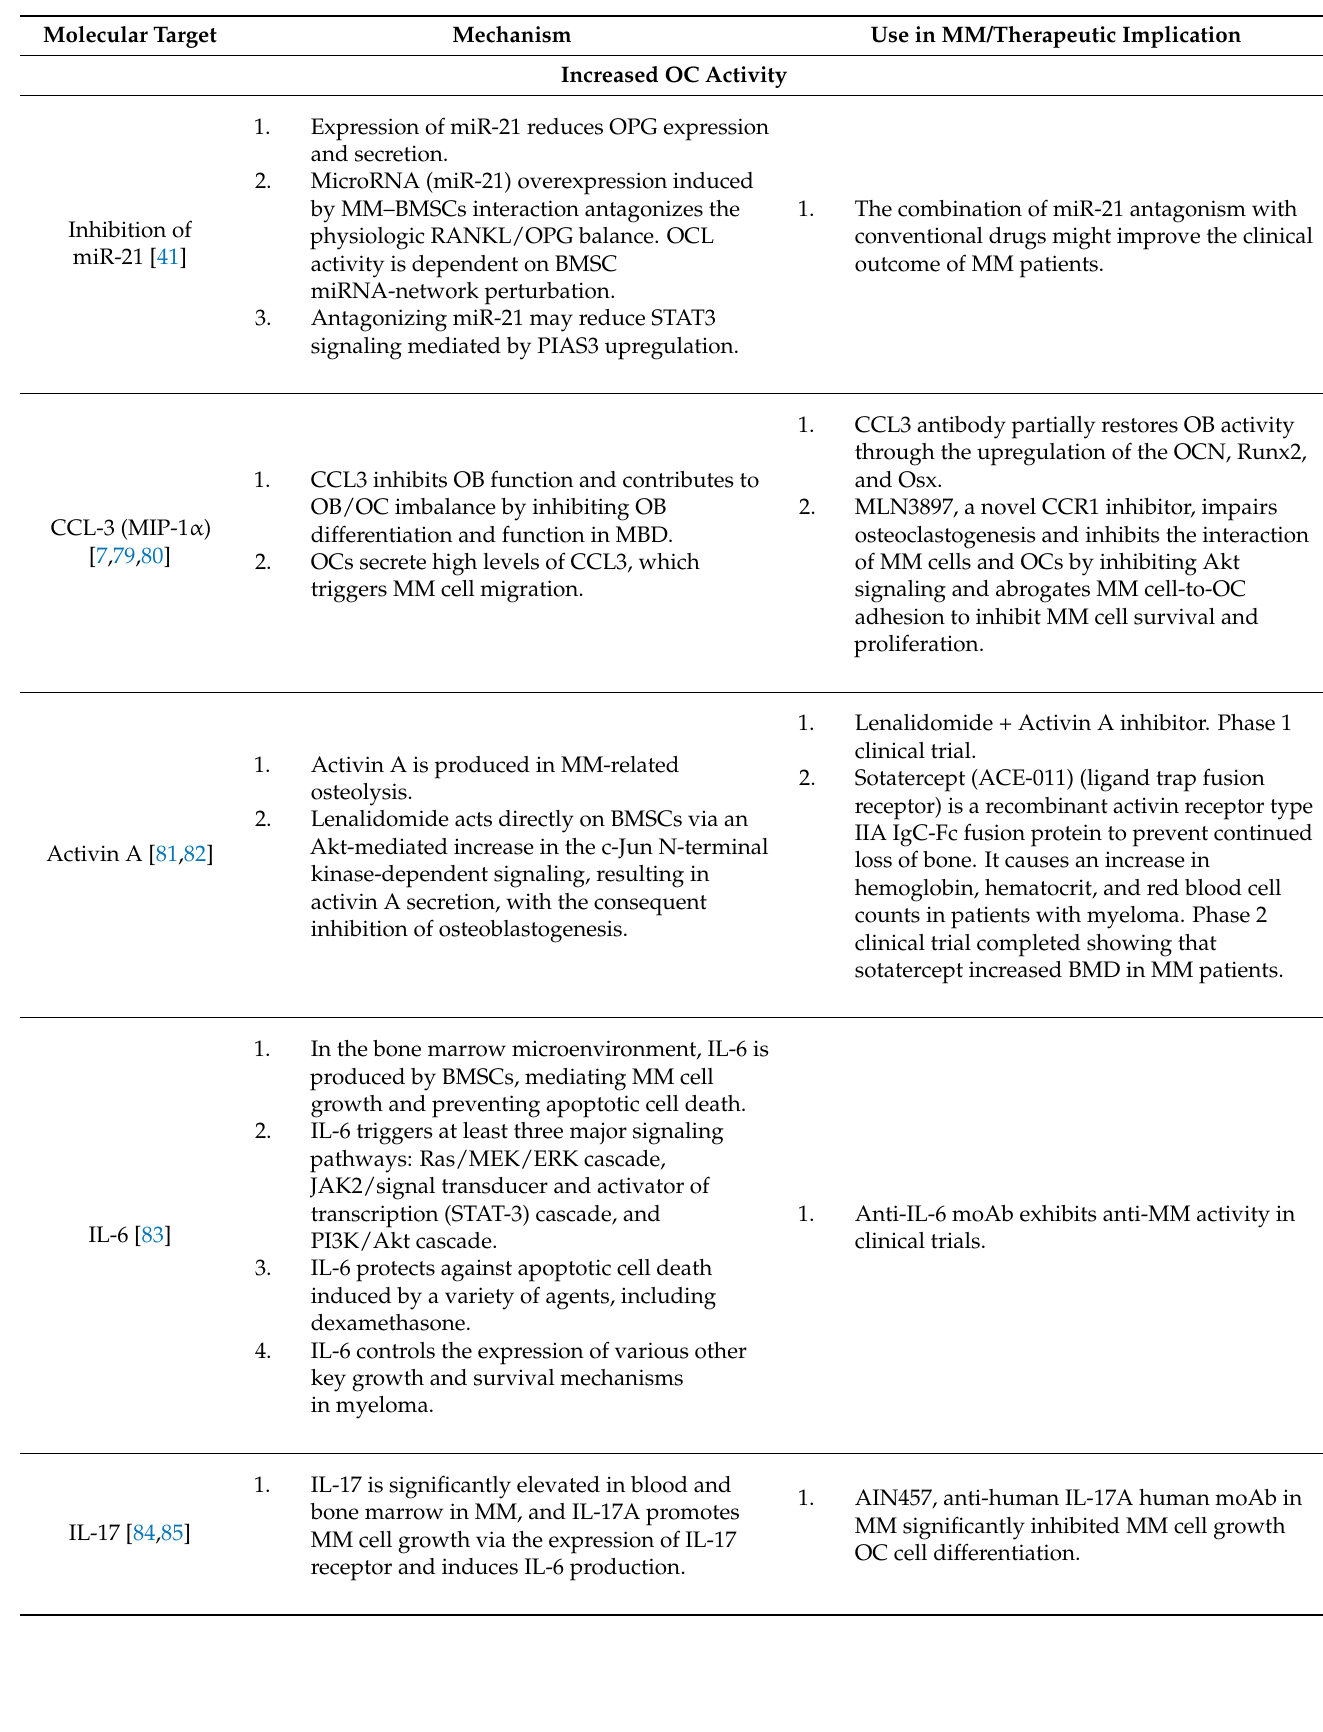
Table 2. Novel agents under